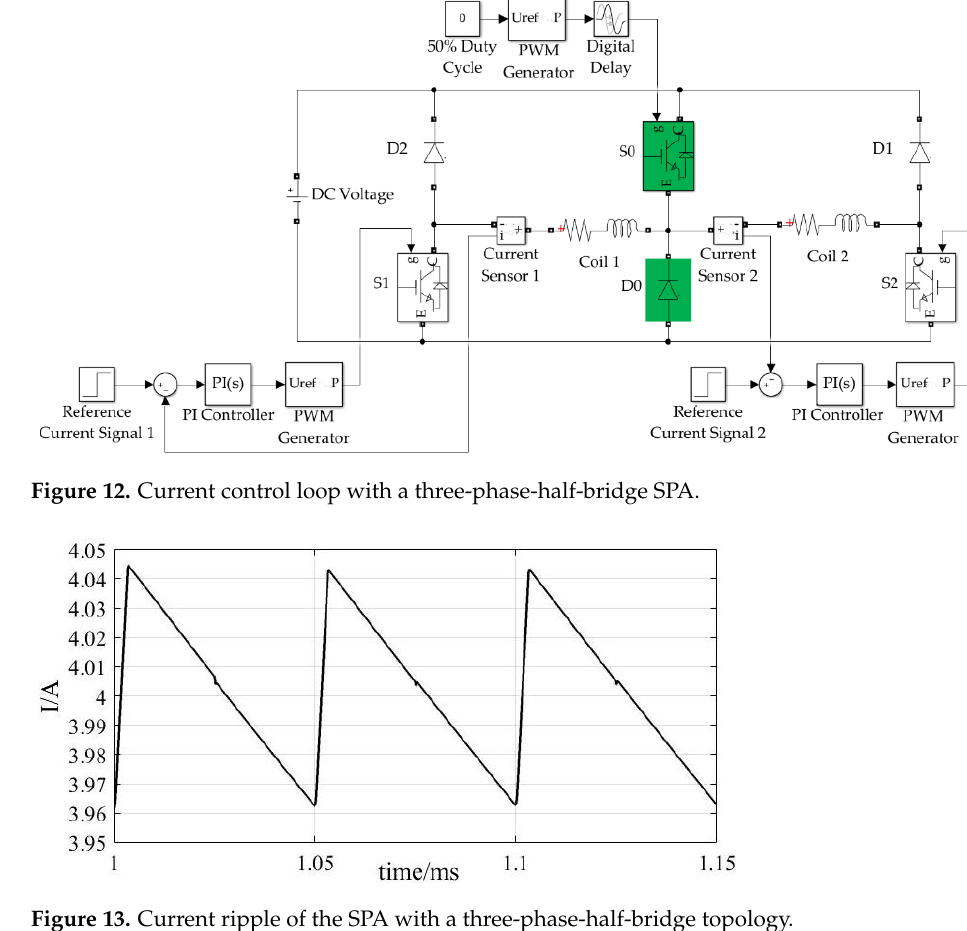
Figure 13. Current ripple of the SPA with a three-phase-half-bridge topology.